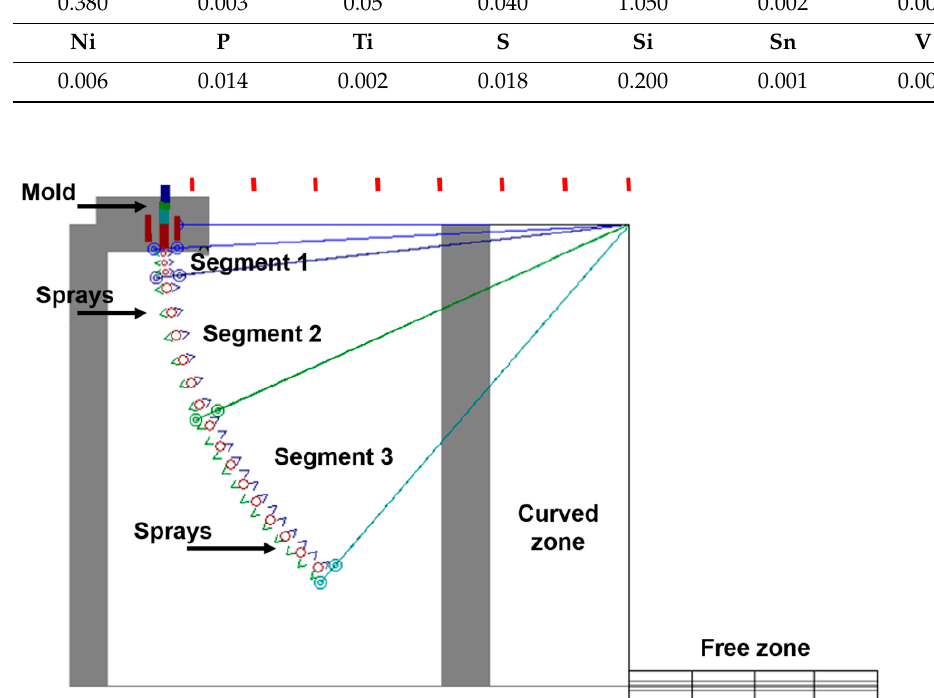
Figure 7. Layout of the billet casting machine corresponding to case 1.